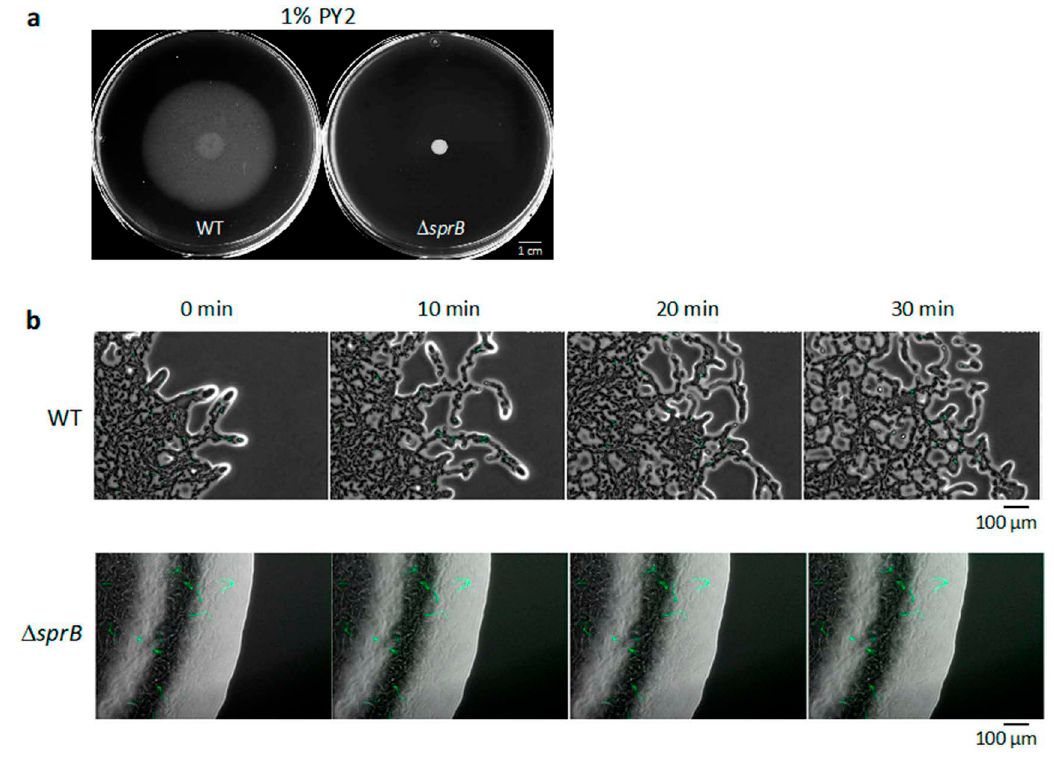
Figure 1. Colony spreading of WT and Δ sprB mutant cells on 1% A-PY2. ( a ) Images of the colonies spreading on 9-cm diameter dishes (5 days). ( b ) Behavior of bacteria in spreading of WT and Δ sprB colonies. Cells expressing GFP in their cytoplasm were added to the inoculated bacterial solution at a concentration of 1%, and movement of the bacterial cells at the colony edge was monitored. Images were recorded by fluorescence microscopy at 30-s intervals for 30 min. Upper panel: WT. At the leading edge of a spreading WT colony on 1% A-PY2, a small cell cluster moved outward at the tip of a branch. Lower panel: Δ sprB mutant. At the leading edge of a nonspreading Δ sprB colony, curved lines of static cells expressing GFP were observed and were interpreted to be cells connected in line. Time is shown at the top left. Selected frames showing the edge of each bacterial colony during 10 min of video captures (see Figure S2).